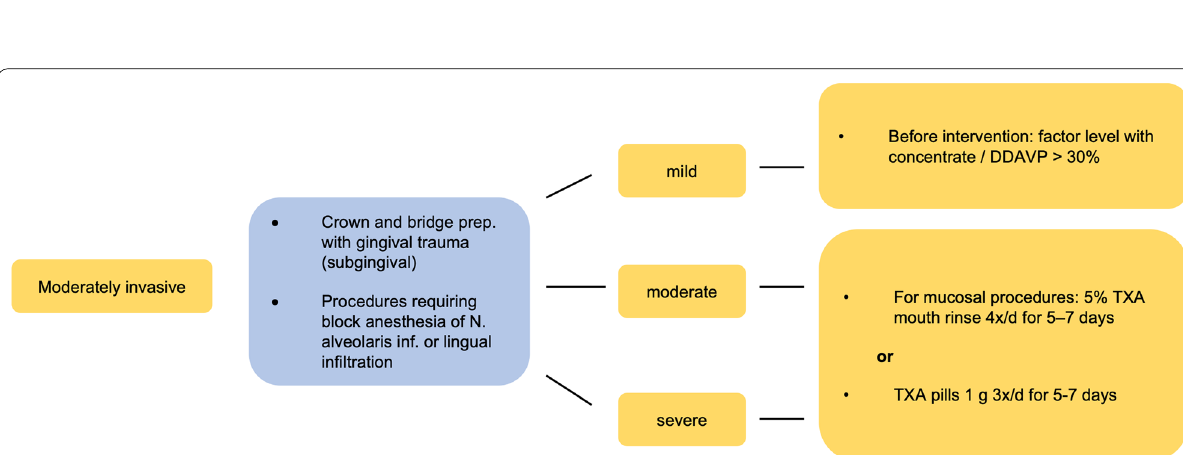
Fig. 3 Exemplary treatment scheme for moderate-risk dental treatments. Moderate risk (yellow) (acc. to [2]). TXA: tranexamic acid; DDAVP: